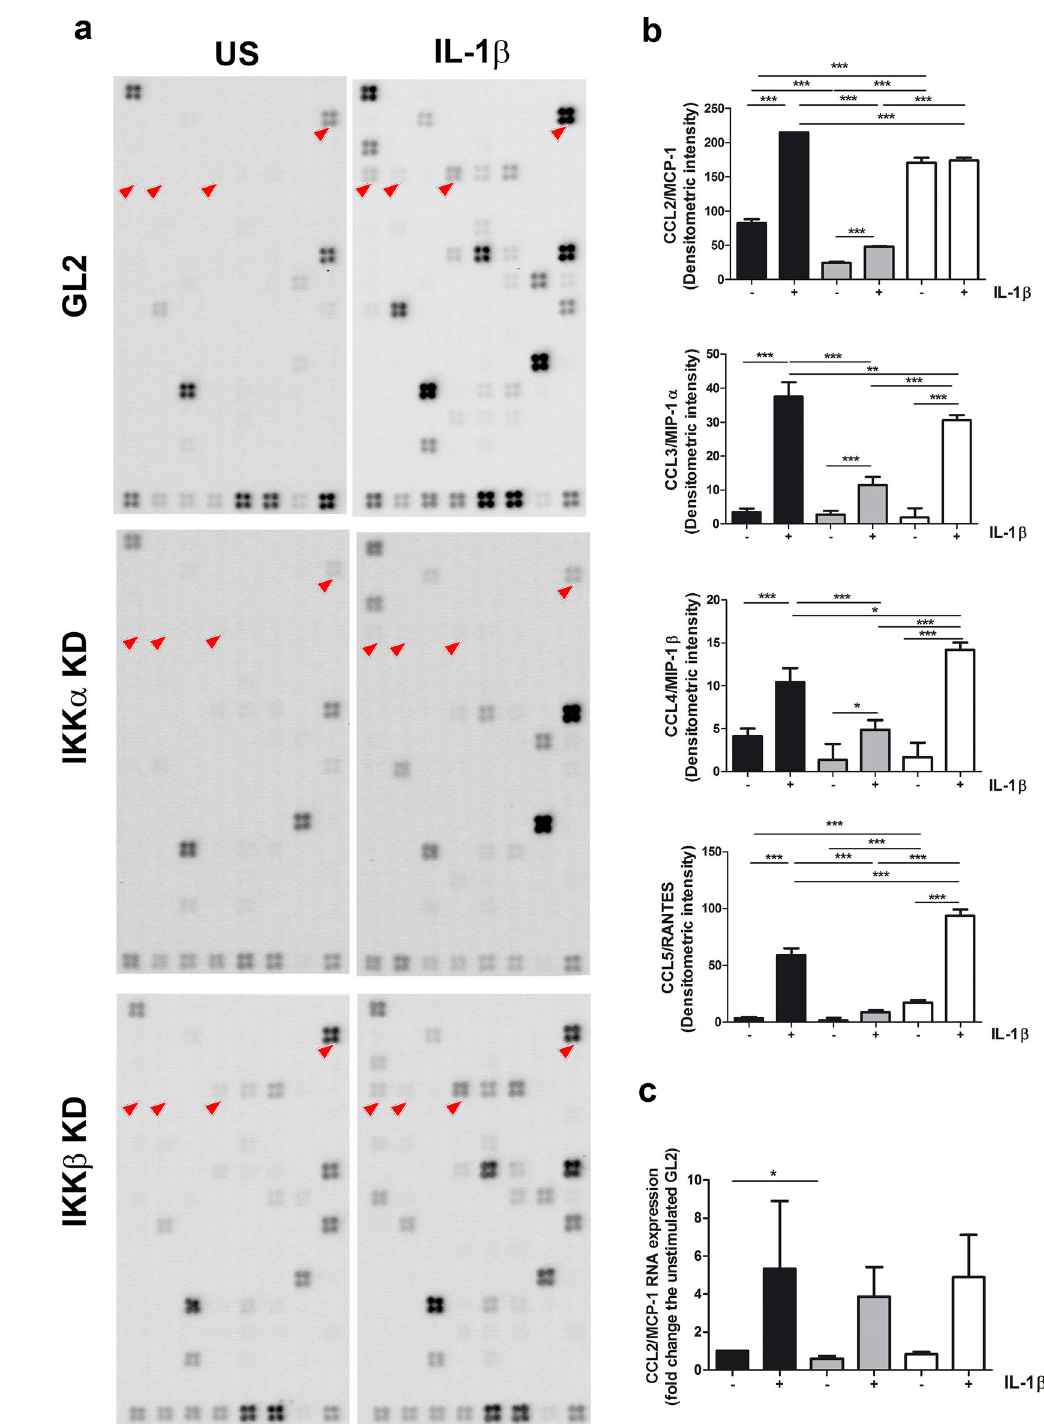
Figure 1. IKK dependency of the transcription of monocyte recruiting chemokines. ( a ) Total RNA obtained from GL2, IKKαKD or IKKβKD chondrocytes in basal conditions or following 8 h exposure to 2 ng/ml IL-1β was probed against the Oligo GEArray microarray human chemokines and receptors microarray (OHS-022, SuperArray). The array layout is indicated in Supplementary Fig. 2. The probe positions for the monocyte active chemokines (CCL2/MCP-1, CCL3/MIP-1α, CCL4/MIP-1β and CCL5/RANTES) are indicated by red arrows. ( b ) For each chemokine, every single dot signal of the quadruplicate was quantified by densitometric measurements, and signals were compared across the different conditions: GL2 (black pattern), IKKαKD (gray pattern) or IKKβKD (white pattern) chondrocytes in control (−) or IL-1β stimulation (8 h, +). The different Y axis scale shows the different expression magnitudes of these chemokines in the three different genotypes. Cumulative results of the four replicates are shown as mean ± SD. Chemokine gene expression levels in both basal and IL-1β stimulated conditions were compared across the different phenotypes by ANOVA, followed by Tukey’s post hoc test. The differences were considered significant when p < 0.05 with: **p < 0.01; and ***p < 0.001. ( c ) Real Time PCR performed with RNA obtained from cultures derived from three different patients confirms an evident IL-1β induction and in basal conditions lower CCL2/MCP-1 RNA in IKKαKD compared to the GL2